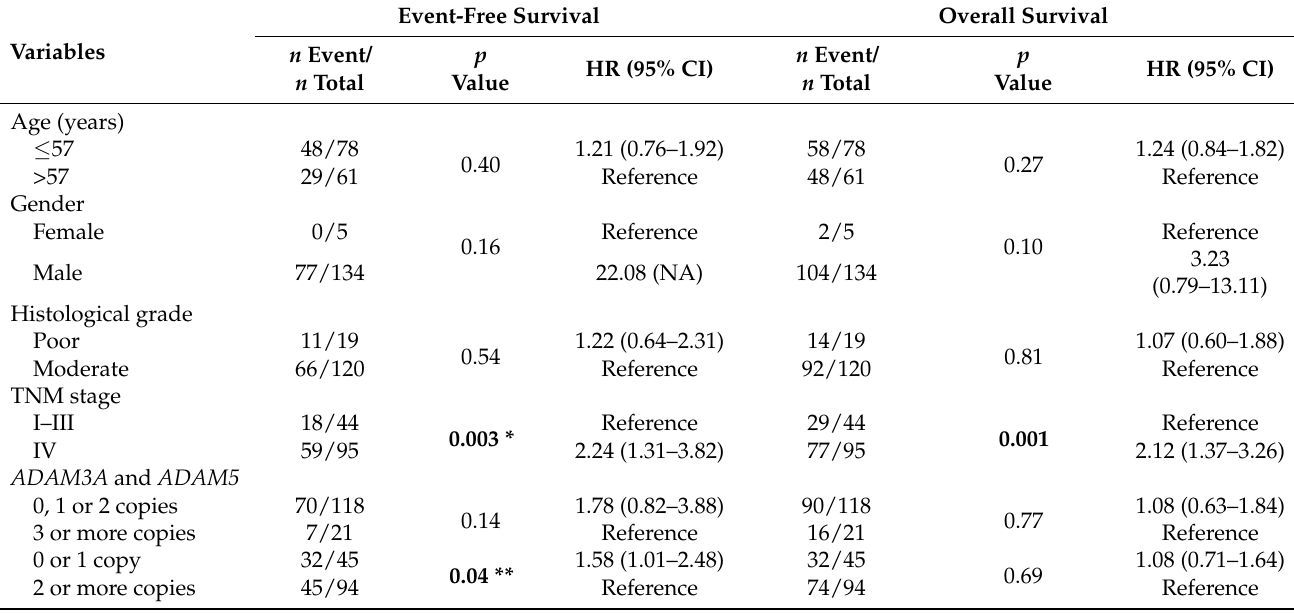
Table 3. Clinical and pathological aspects and ADAM3A and ADAM5 copy number variation in